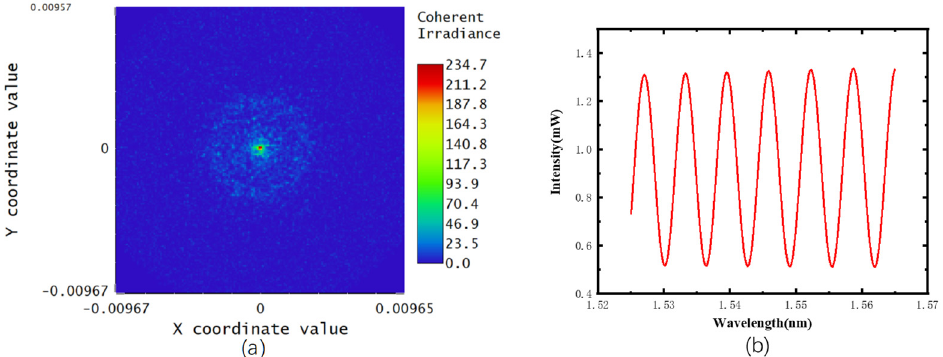
Figure 8. Ray tracing and wavelength scanning results. ( a ) simulation result for one single wavelength, ( b ) spectrum formed by simulation results of every wavelength within the range of 1525~1565 nm.